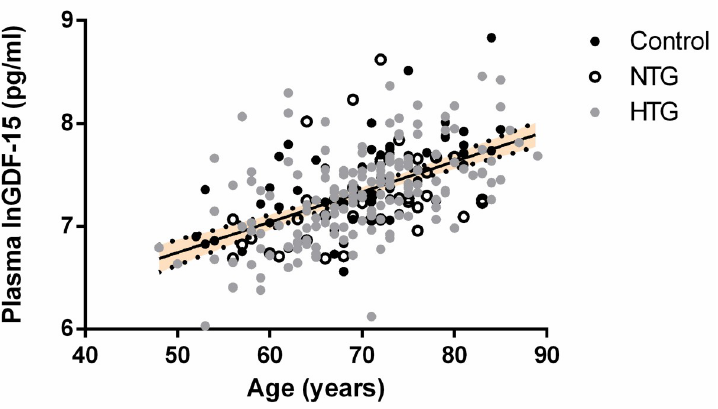
Fig 2. Correlation between plasma GDF-15 concentration (Ln transformed pg/ml) and age in a univariate linear regression model. LnGDF-15 was significantly correlated with age ( β = 0.532; p < 0.001).